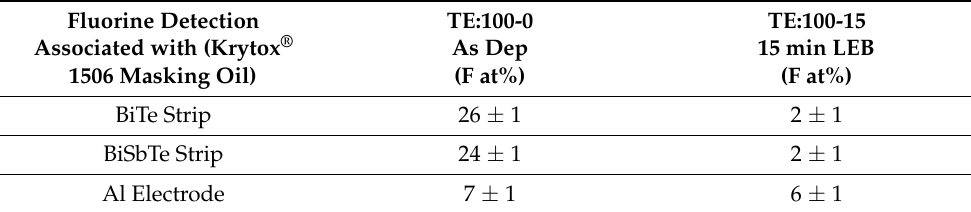
Table 2. EDX was used to detect fluorine contamination associated with coating BiTe and BiSbTe TEG semiconductor strips over residual masking oil. Fluorine found within unmasked regions, i.e., Al electrodes, were possibly associated with a reaction between condensing Al and simultaneous generated Oil Vapour cloud. Error represented variation of three randomly selected